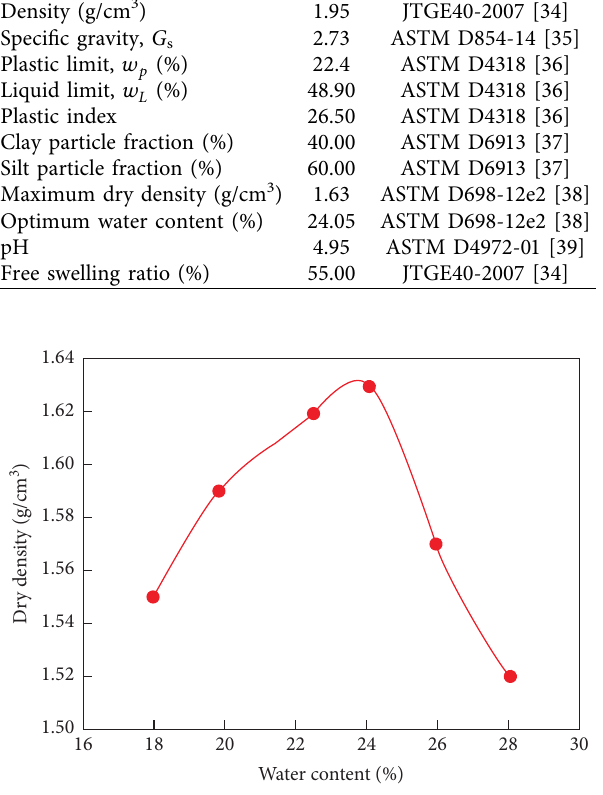
Figure 1: The compaction curve of the tested